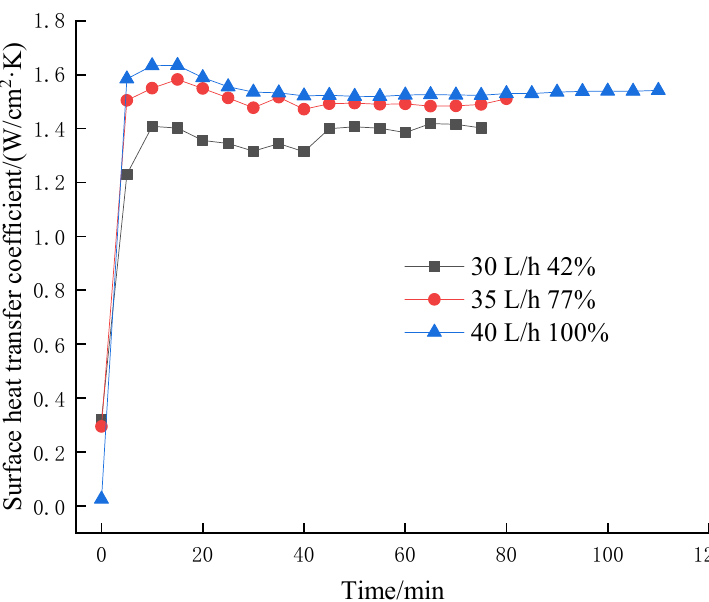
Figure 10. The influence of coverage rate of changing flow rate at 150 W/cm 2 on transient surface heat transfer coefficient.